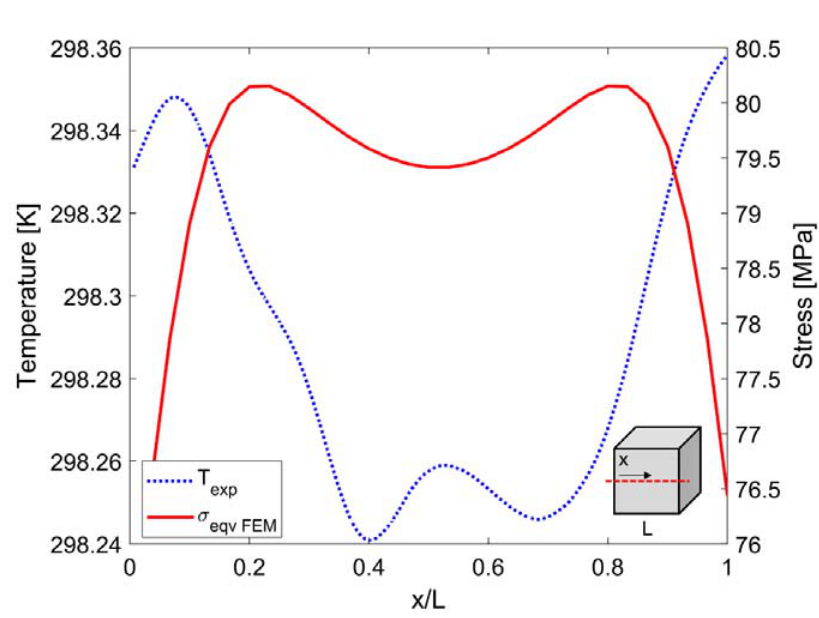
Figure 13: Experimental temperature and FEM equivalent von Mises stress curves on a median horizontal section of the